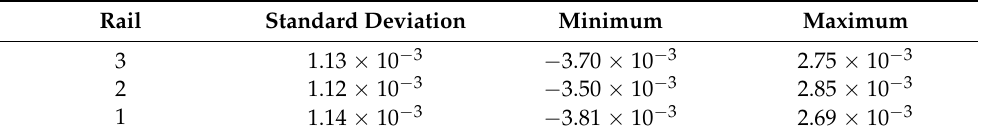
Table 4. A comparison of the basic statistical characteristics of vertical displacements (in m) of the wheelset for various rail